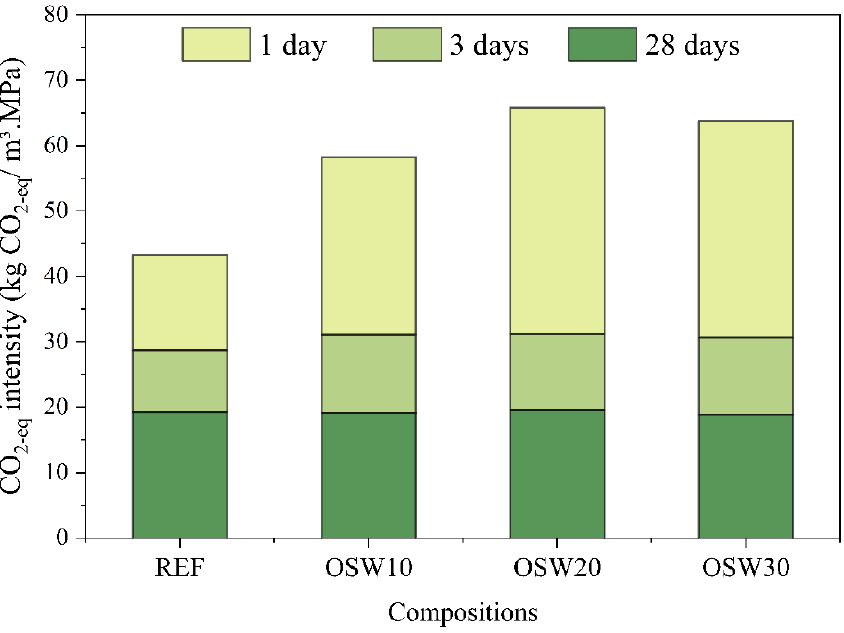
Figure 13. CO 2-eq intensity (kg CO 2-eq /MPa.m 3 of paste) at each age.